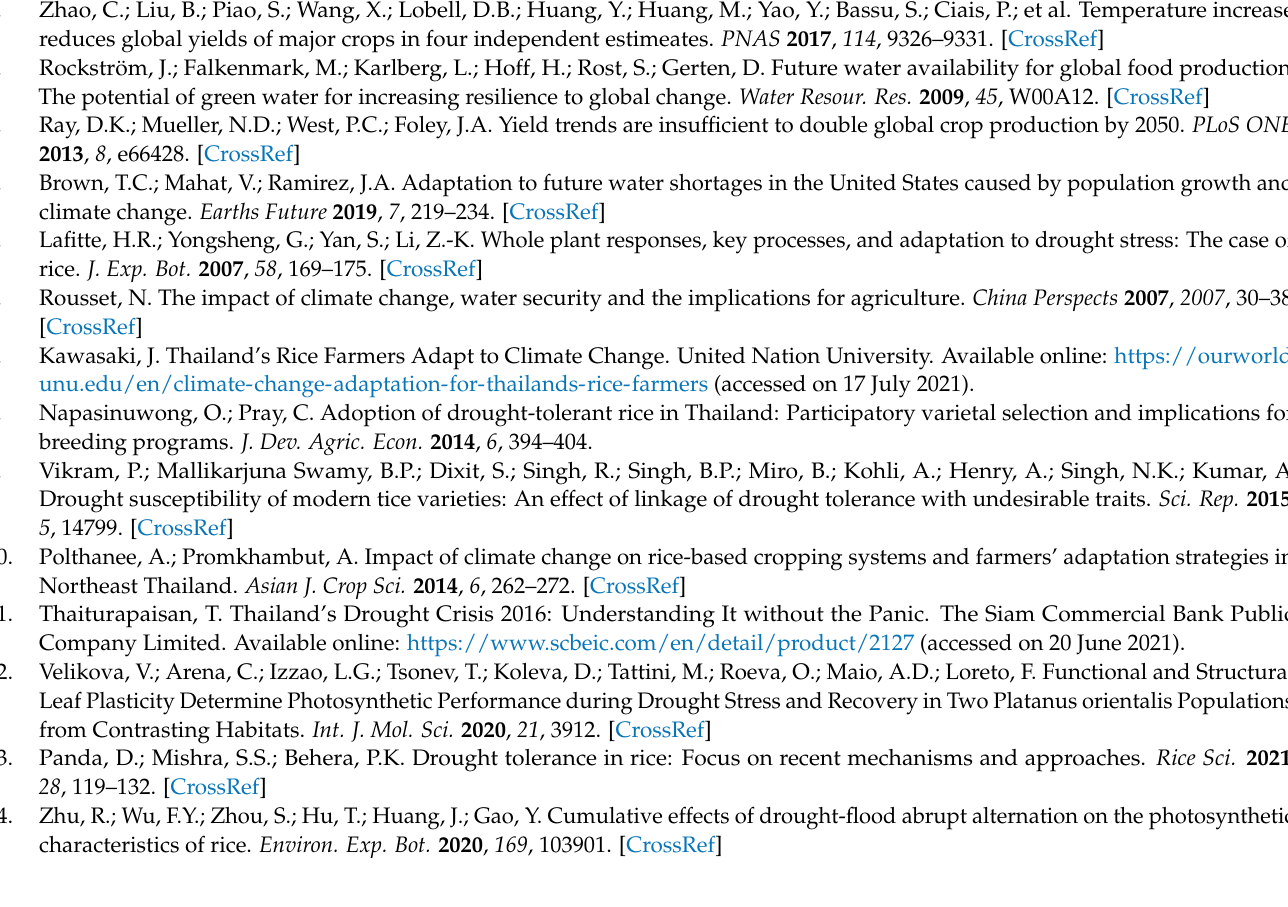
S1 Mean value of KDML105-CSSLs for traits plasticity. Table S2: The physiological and stomatal trait loading scores for each principal component under drought stress plasticity; the bold number indicated the maximum magnitude of loading score among the three